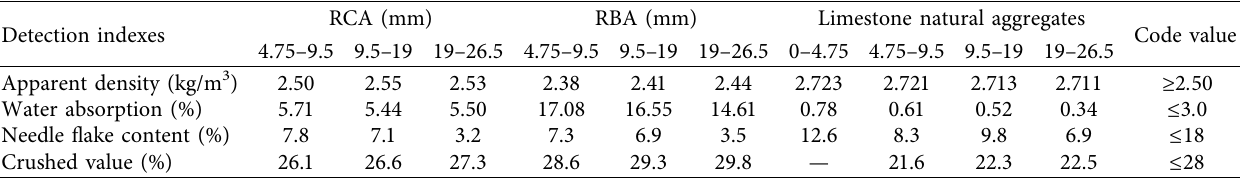
Figure 1: Source materials. (a) RCA. (b) RBA. Table 1: Characterisation of aggregates.